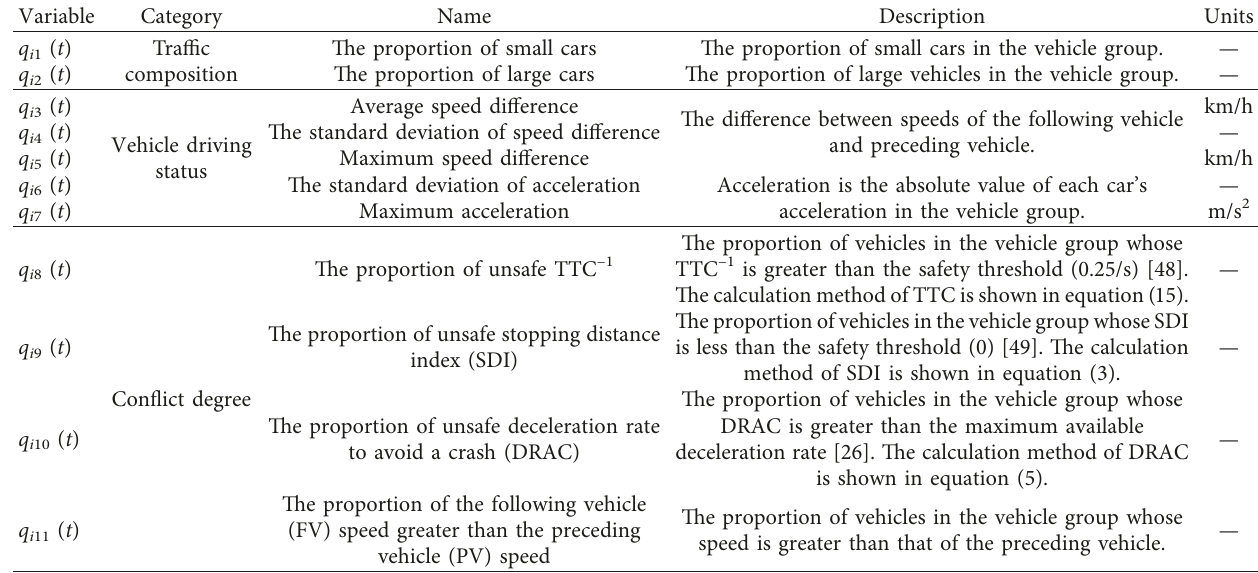
Table 2: Vehicle group rear-end collision risk measurement